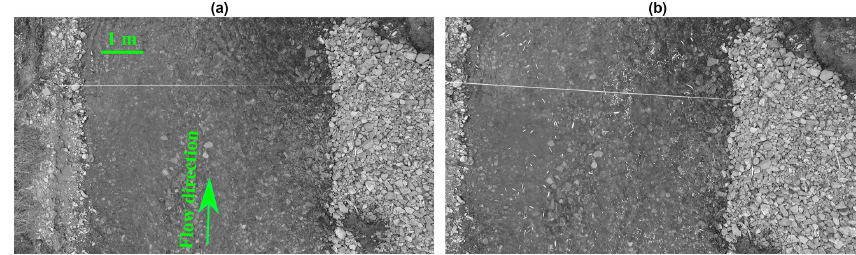
Figure 6. Region of interest in case study 3 (Basento river). (a) Initial frame. (b) Frame no. 700. Table 1. Metadata of the videos used in this study.